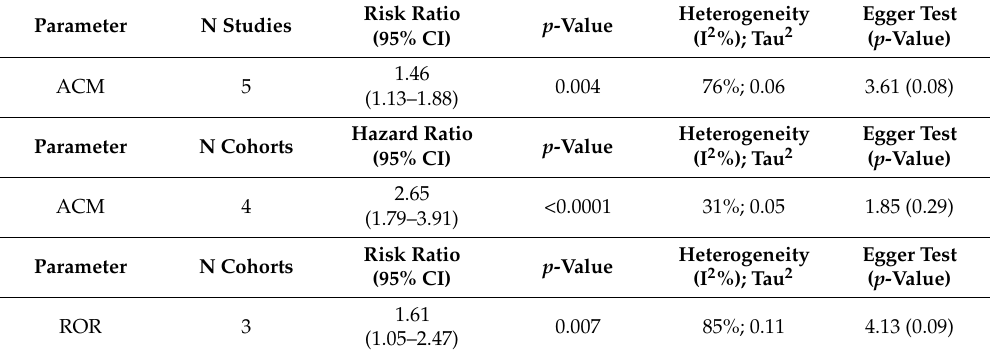
Table 1. Risk Ratio and Hazard Ratio for survival indexes of PDAC patients based on high grade-TB vs. low grade TB